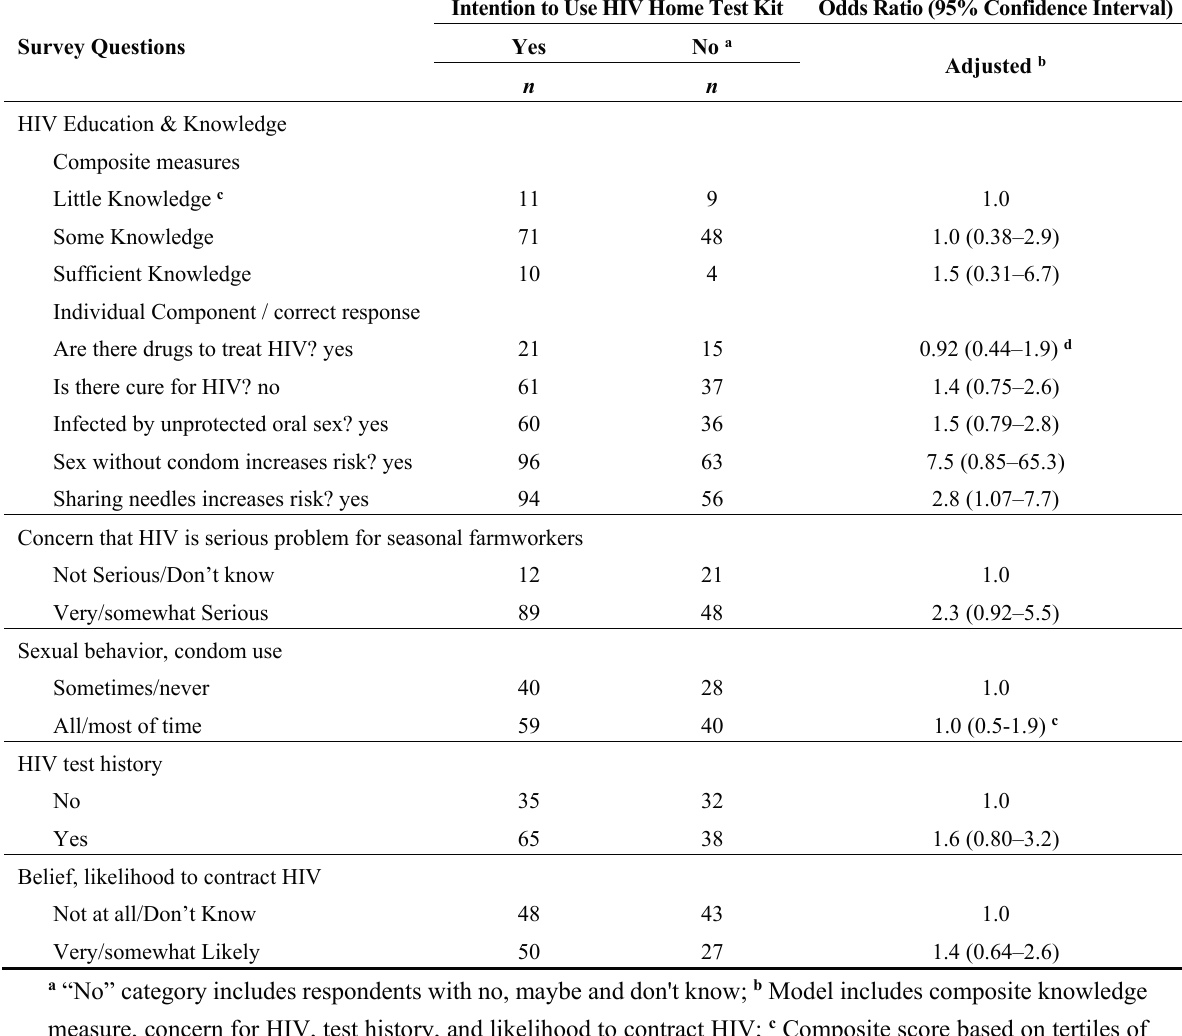
Table 3. Association between HIV knowledge, attitudes, and beliefs and intention to use a HIV home-test kit among Latino farmworkers, North